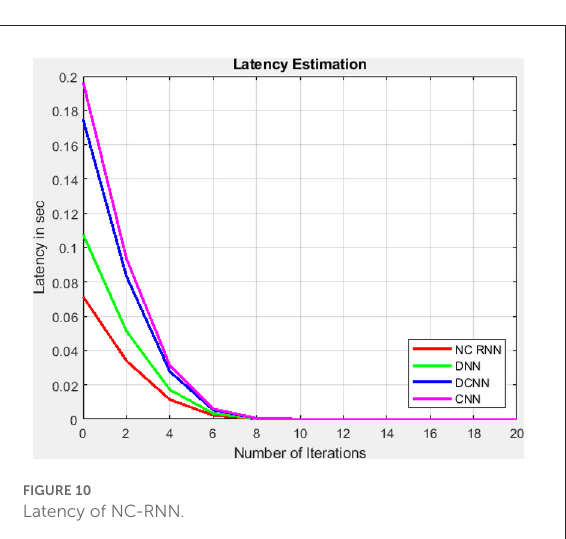
FIGURE10 Latency of